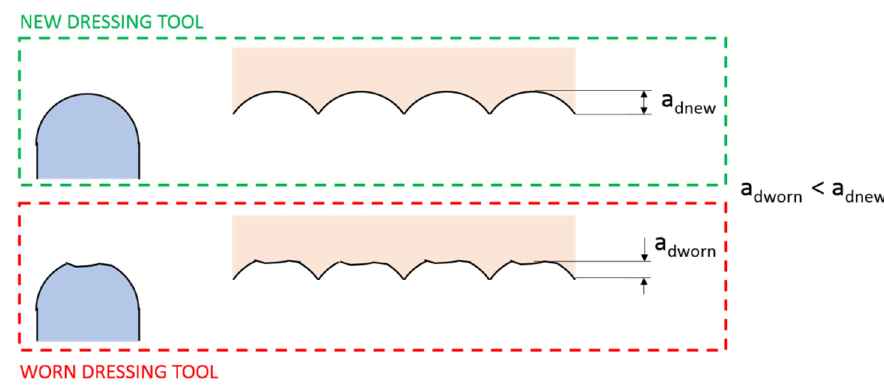
Figure 1. Influence of the worn rotary dressing tool on the wheel surface.